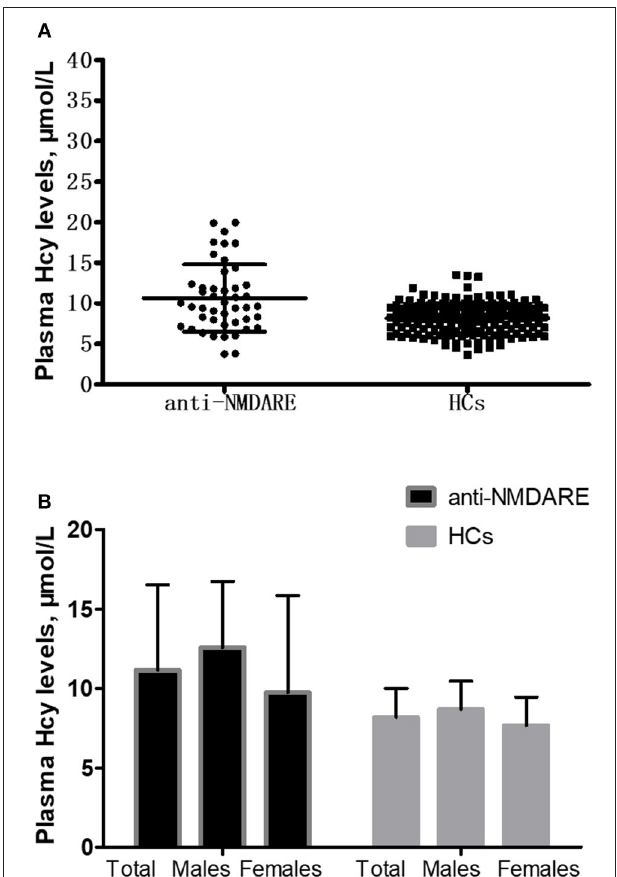
FIGURE 1 | Comparison of homocysteine (Hcy) levels between anti-NMDAR encephalitis (anti-NMDARE) patients and healthy controls (HCs). (A) Comparison of Hcy levels between the anti-NMDAR encephalitis patients ( n = 45) and healthy controls (HCs) ( n = 179), p < 0.001. (B) Comparison of Hcy levels between the anti-NMDAR encephalitis patients and HCs according to gender. Anti-NMDAR encephalitis patients (male) vs. HCs (male), p < 0.001; anti-NMDAR encephalitis patients (female) vs. HCs (female), p = 0.173.